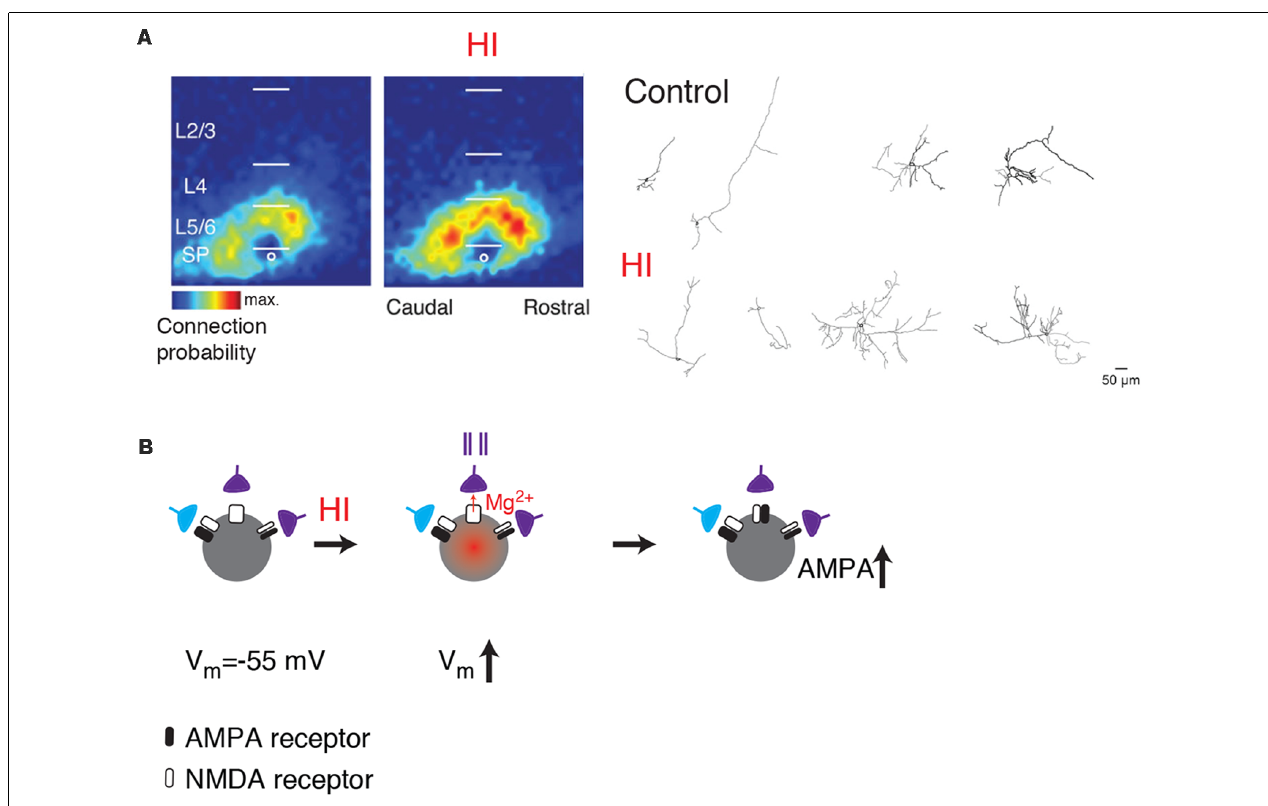
FIGURE 3 | (A) SPNs show functional and morphological hyperconnectivity after hypoxic-ischemic (HI; from Sheikh et al., 2019; no copyright permission as required for use of this image). Shown are LSPS maps of connection probability and neurolucida reconstructions. (B) Cartoon illustrating how depolarization caused by HI can lead to unsilencing of synapses on SPNs (middle). If presynaptic cells are active (indicated by spike train), the coincidence between presynaptic activity and postsynaptic depolarization might result in a subsequent increase in AMPARs (right,